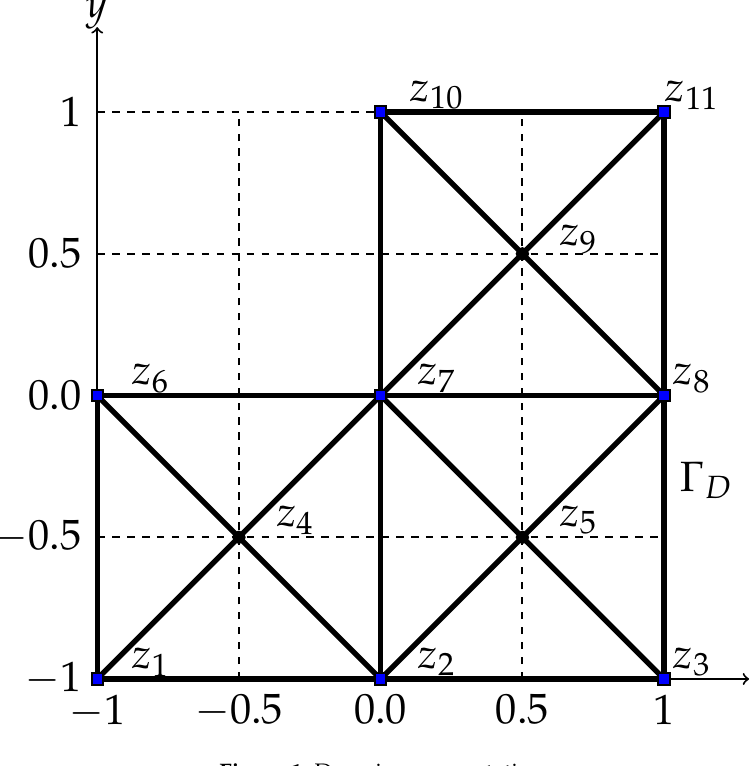
Figure 1. Domain representation. Table 1. Arrays c4n , n4e and dir